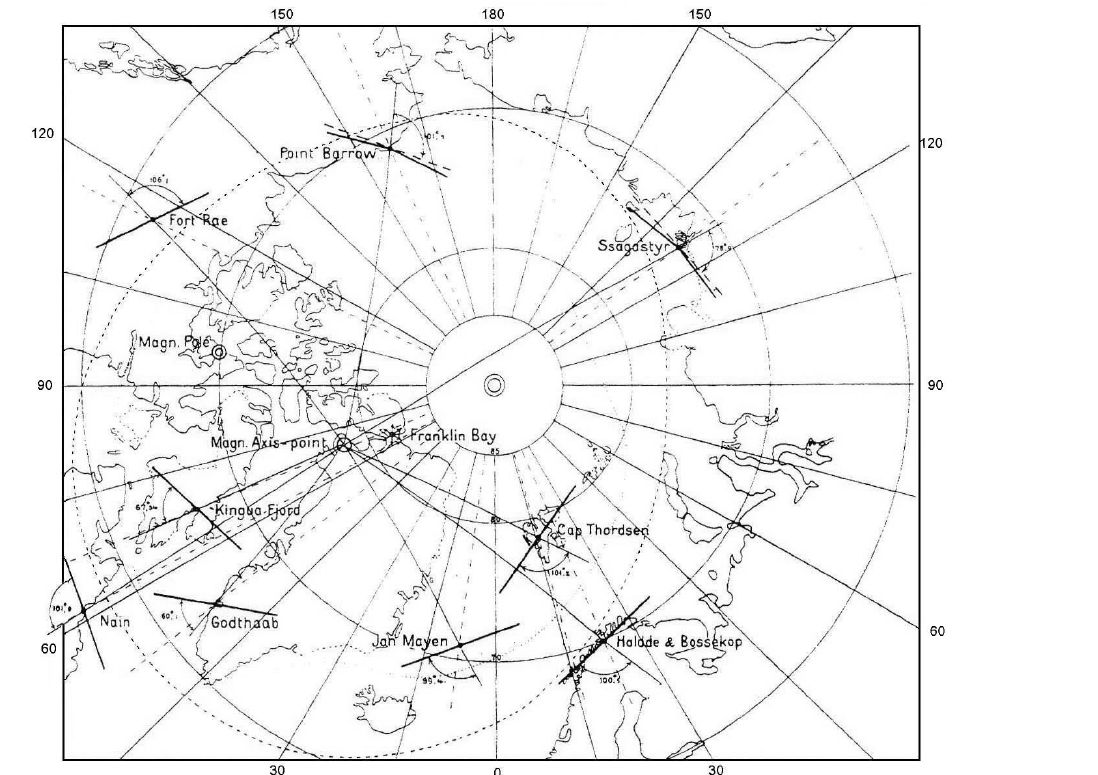
Figure 7. Mean direction of auroral arcs along the auroral zone referred to the geomagnetic meridians (Vegard and Krogness, 1920).